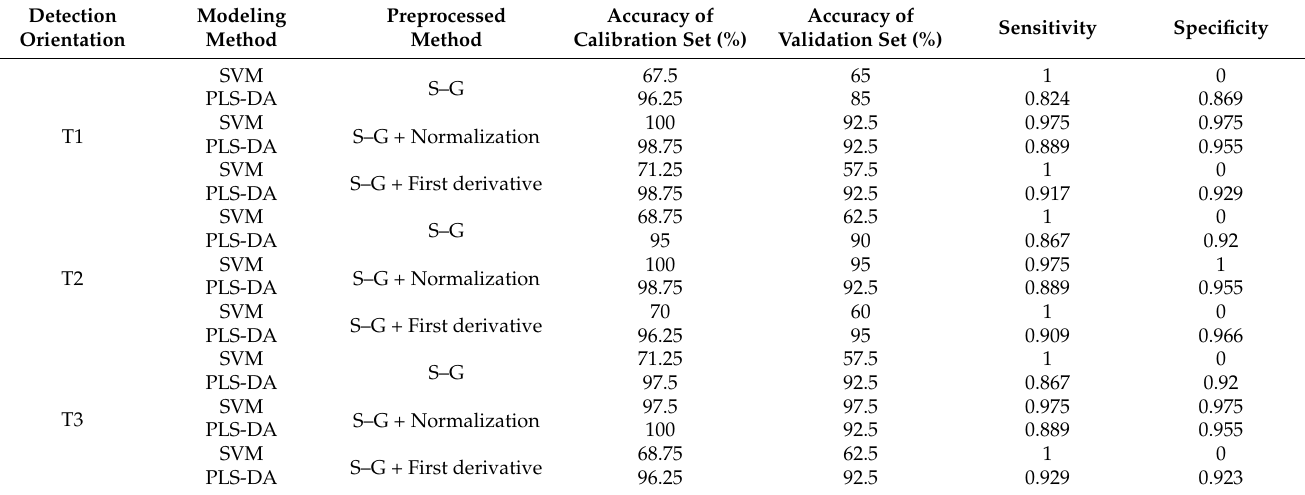
Table 1. The classification performance of the SVM model and the PLS-DA model obtained by using different preprocessing methods in the T1, T2, and T3 orientations (stationary spectrum).